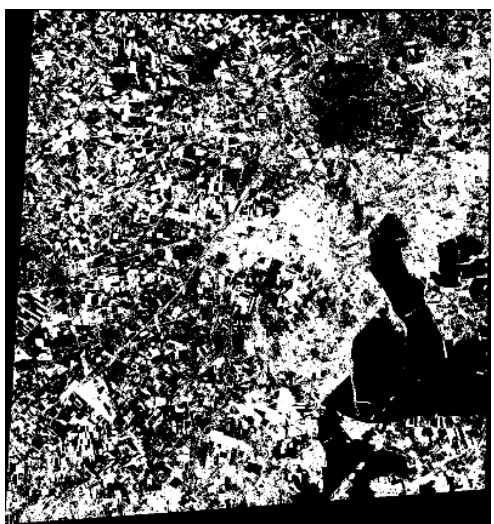
Figure 8 . Cereal crop mask.